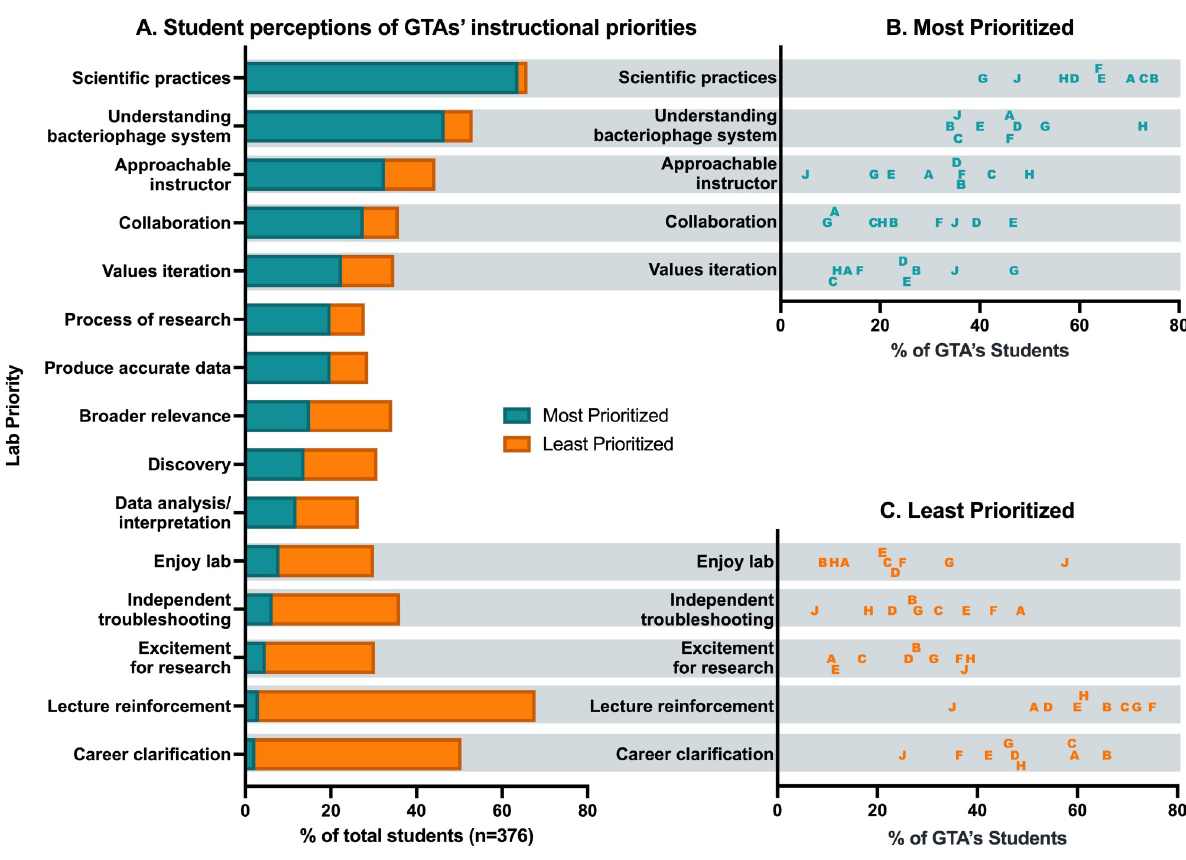
Fig 2. GTAs emphasized different lab priorities. (A) The percent of students overall who reported that each item was among the most (blue bar) or least (orange bar) prioritized for their GTA. Students reported that items near the top of the panel (i.e., "Scientific practices"; “Understanding bacteriophage system”) were most prioritized by their GTA, while items near the bottom of the panel (i.e., “Lecture reinforcement”; “Career clarification”) were least prioritized. (B) The percent of each GTA’s students who reported that specific items were most prioritized by their GTA. (C) The percent of each GTA’s students who reported that specific items were least prioritized by their GTA. Letters in (B) and (C) identify the students of individual GTAs, demonstrating that students of different GTAs differed in their perspectives of the importance of each item to their GTAs.